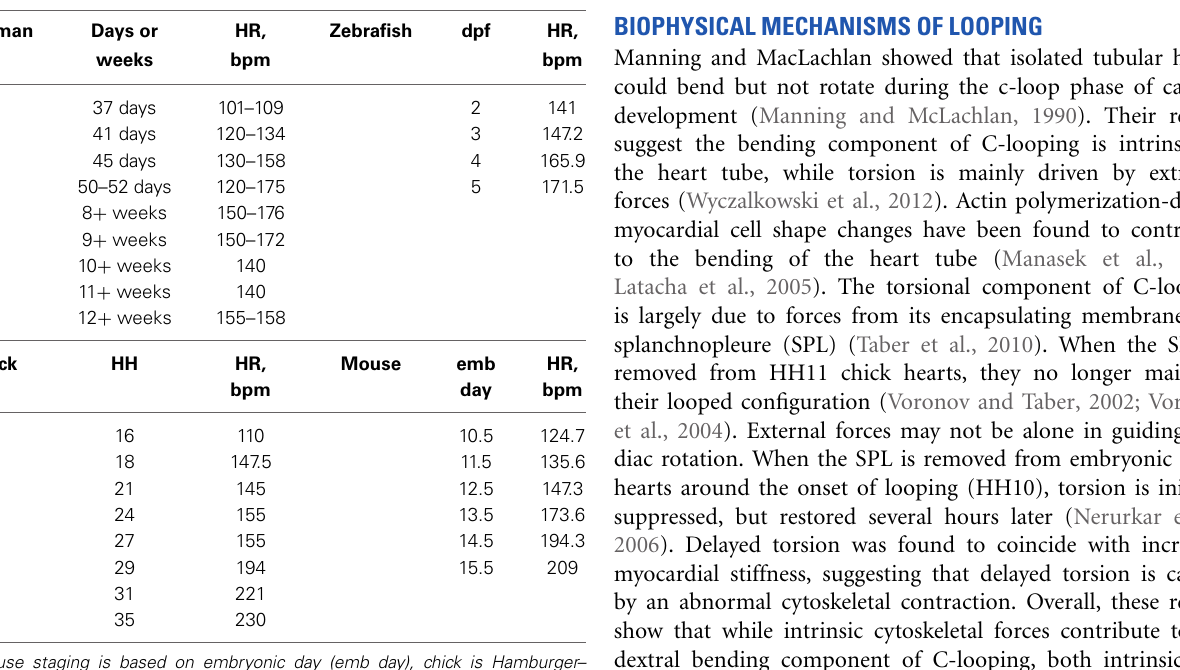
Table 2 | Heart rate (HR) in beats per minute (bpm) across developmental animal models.